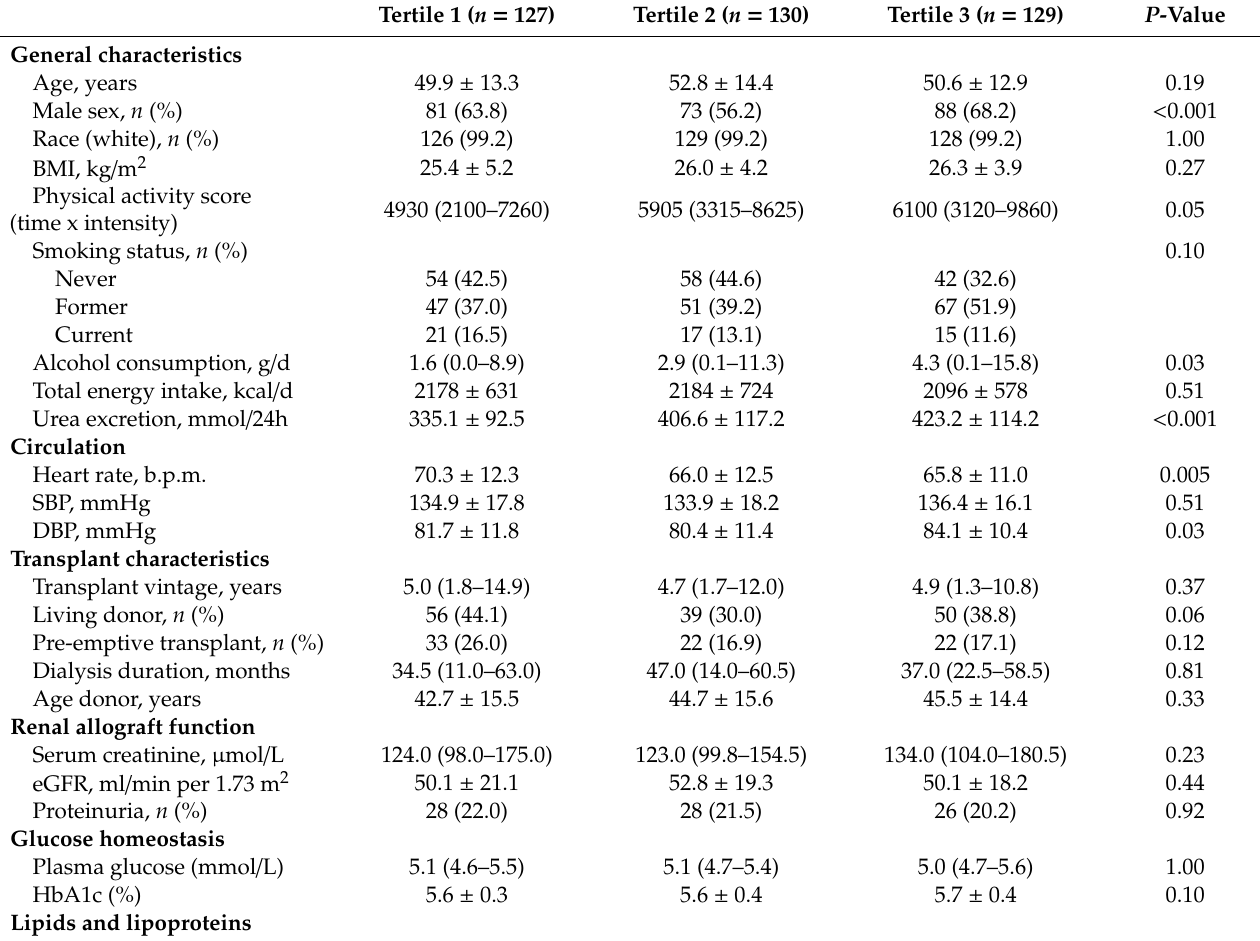
Table 2. Baseline characteristics of non-diabetic renal transplant recipients according to tertiles of total BCAA ( n =